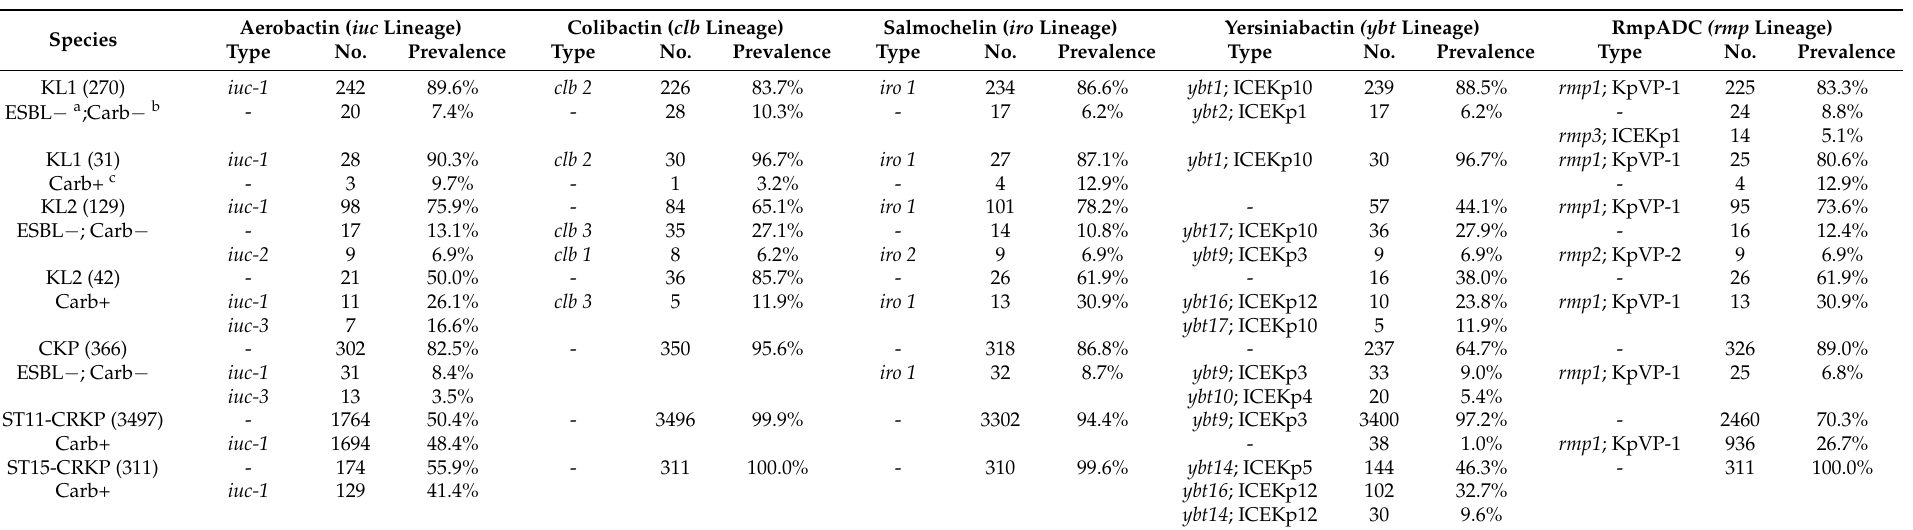
Table 1. Virulence genes of HvKP and CKP with antimicrobial sensitivity and